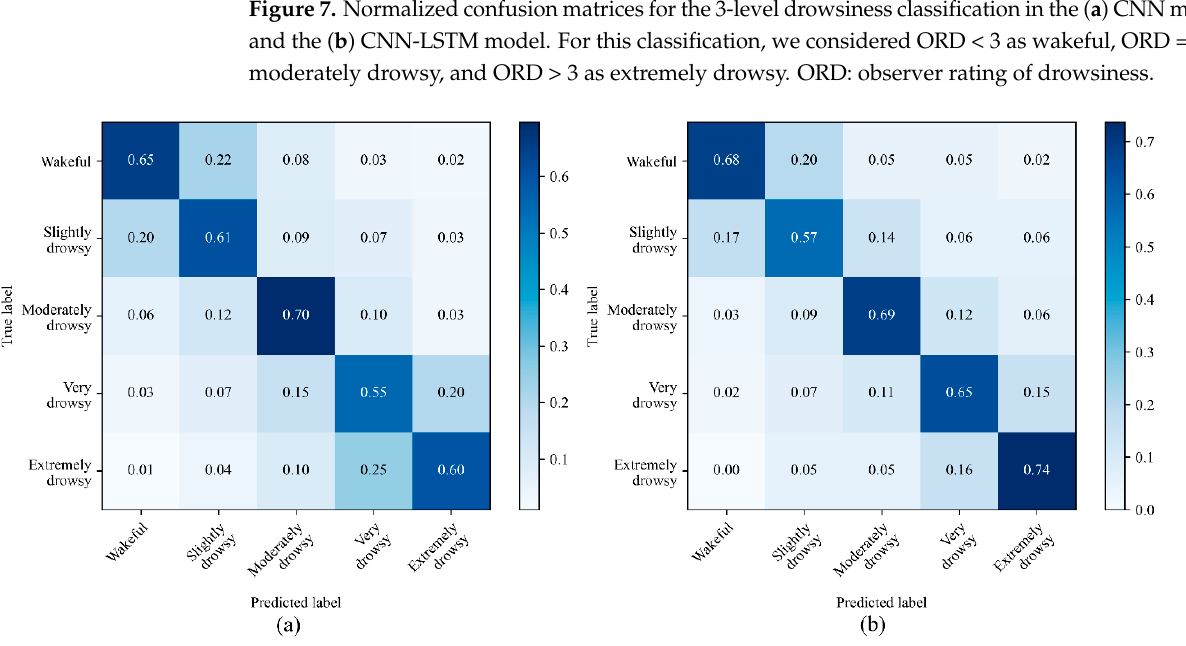
Figure 8. Normalized confusion matrices for 5-level drowsiness detection in the ( a ) CNN model and the ( b ) CNN-LSTM model.